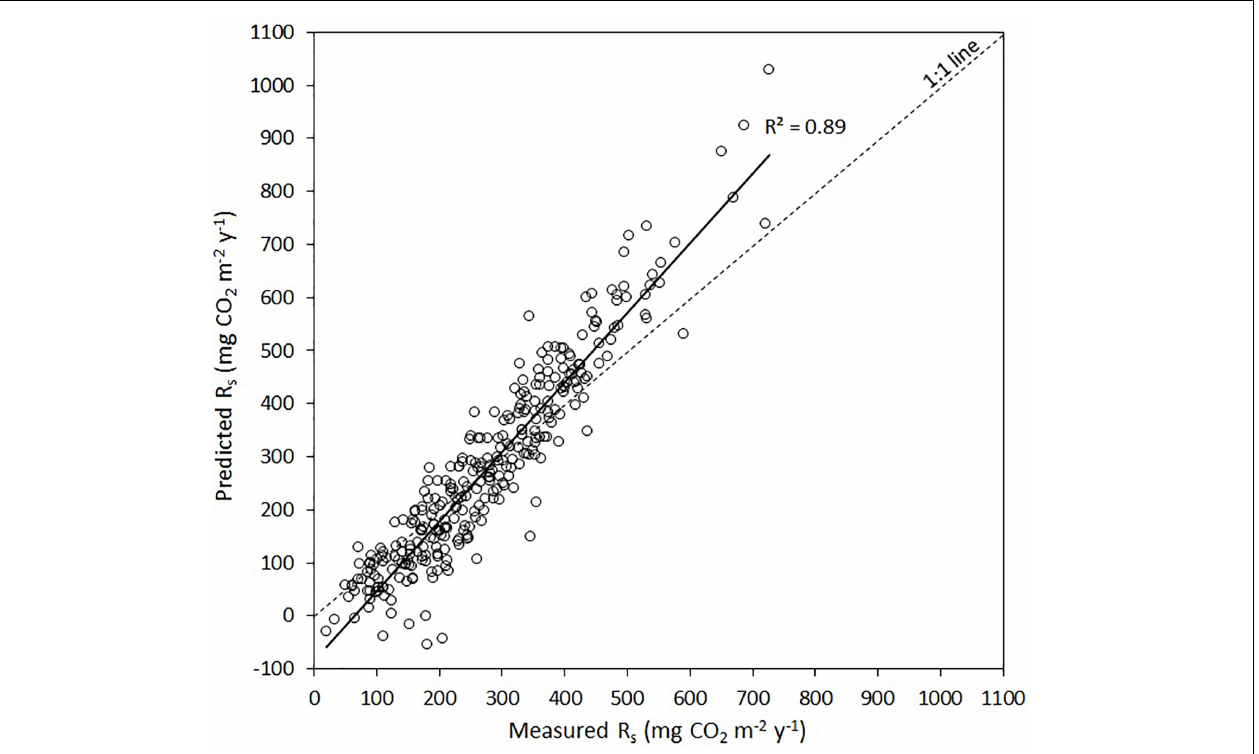
FIGURE 3 | Measured soil respiration rates (R s ) vs. predicted R s after the two stage modeling approach, i.e., exponential of the raw R s data and soil temperature ( Figure 2 and Table 3 ) followed by a multiple linear regression of the residuals ( Table 4 ). The solid line is the linear regression between measured vs. predicted R s , whereas the dashed line is the 1:1